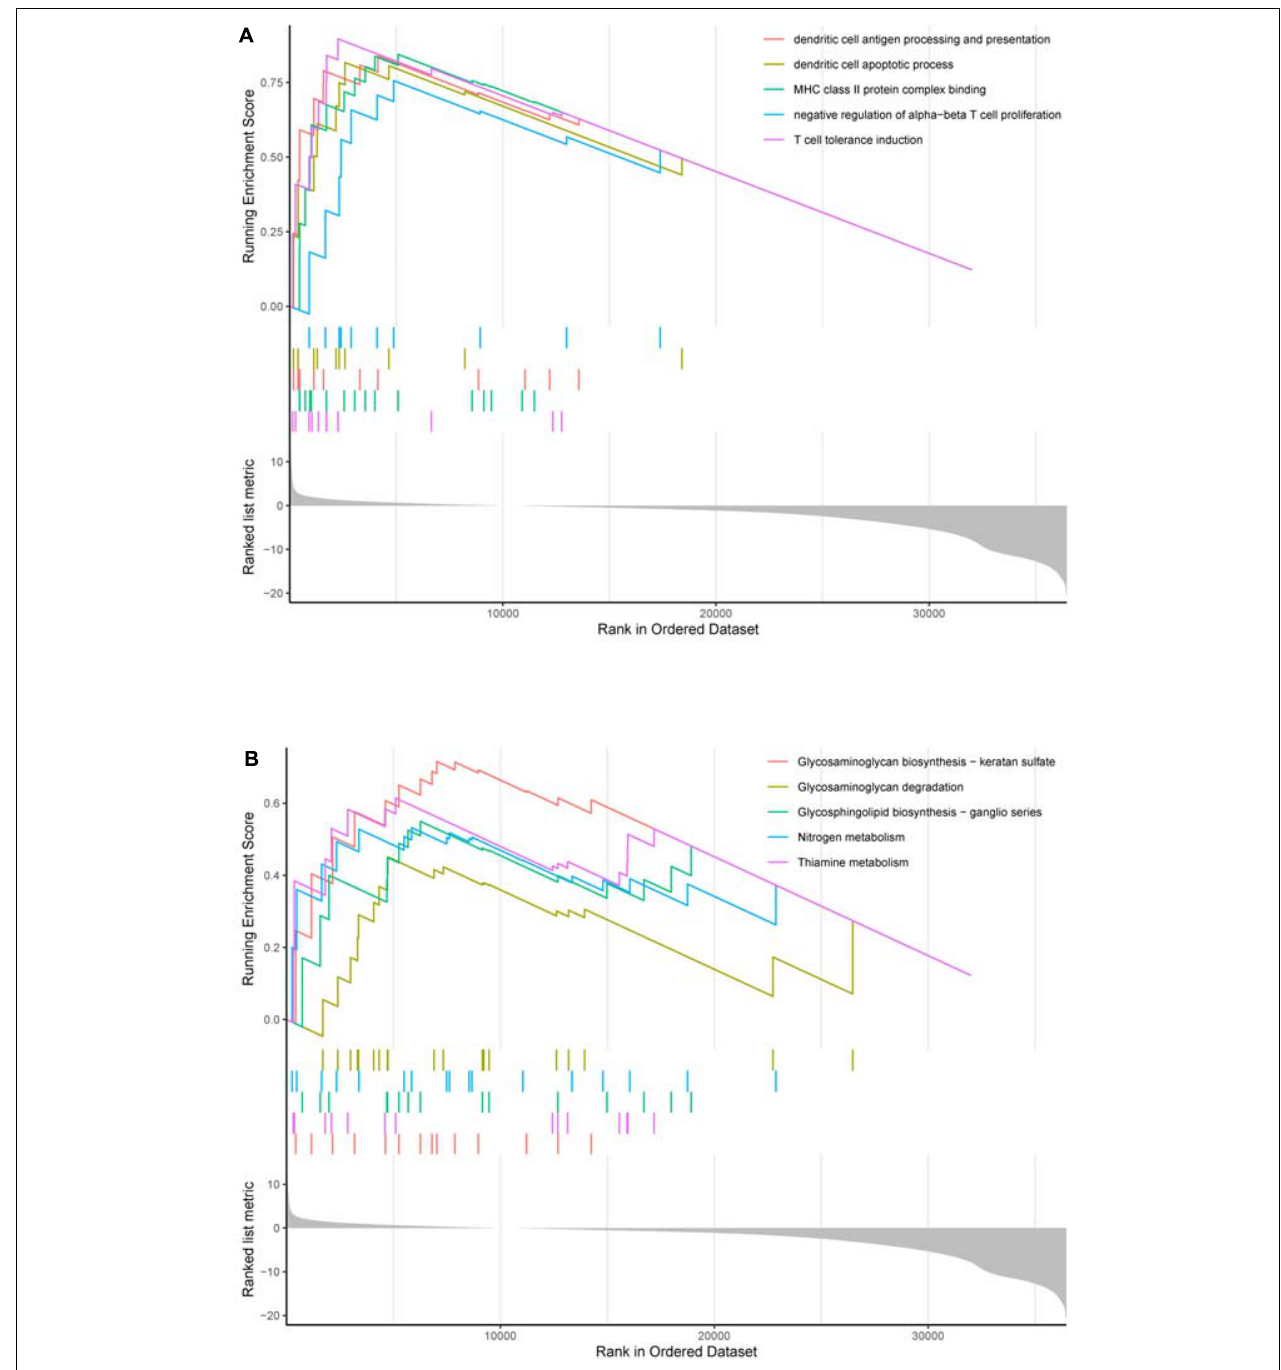
FIGURE 9 | GSEA enrichment analysis. (A) GO enrichment result. In the upper section, the highest score of each GO term is the GO enrichment score. These GO terms are significantly enriched in the high hypoxia group. (B) KEGG enrichment result. In the upper section, the highest score of each KEGG pathway is the KEGG enrichment score. These KEGG pathways are significantly enriched in the high hypoxia